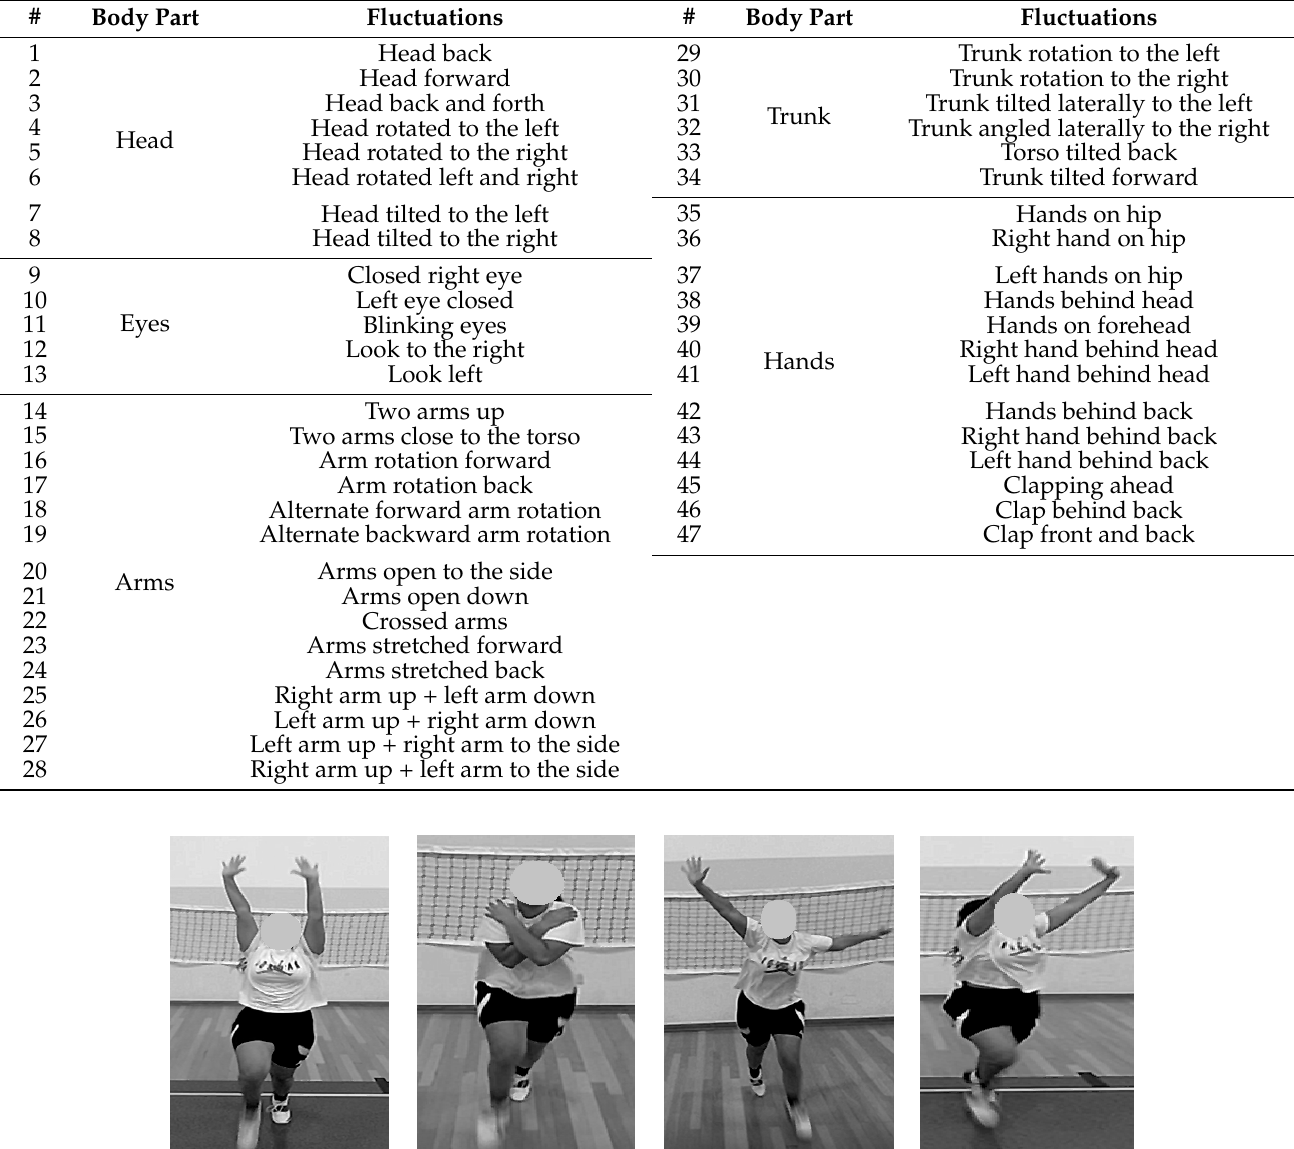
Table 1. Examples of the fluctuations performed during differential repeated sprint training interventions.